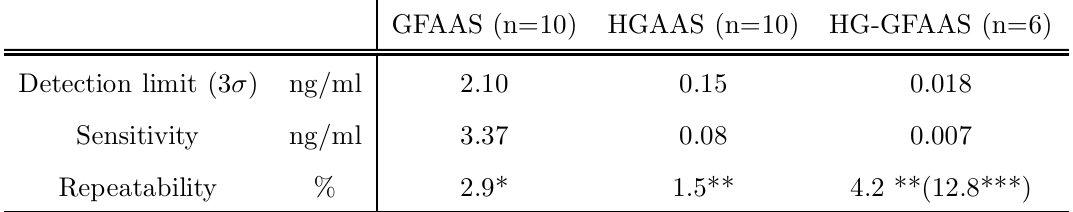
Table 3 Fundamental parameters of the analytical method for the determination of selenium by di¬erent variations of the atomic absorption spectrometry method.